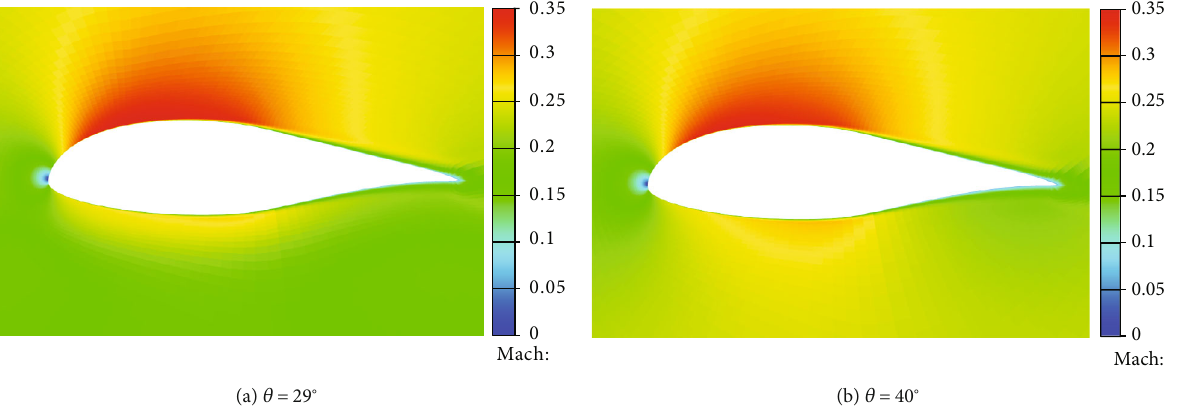
Figure 20: Mach number contours in di ff erent tilt angles.